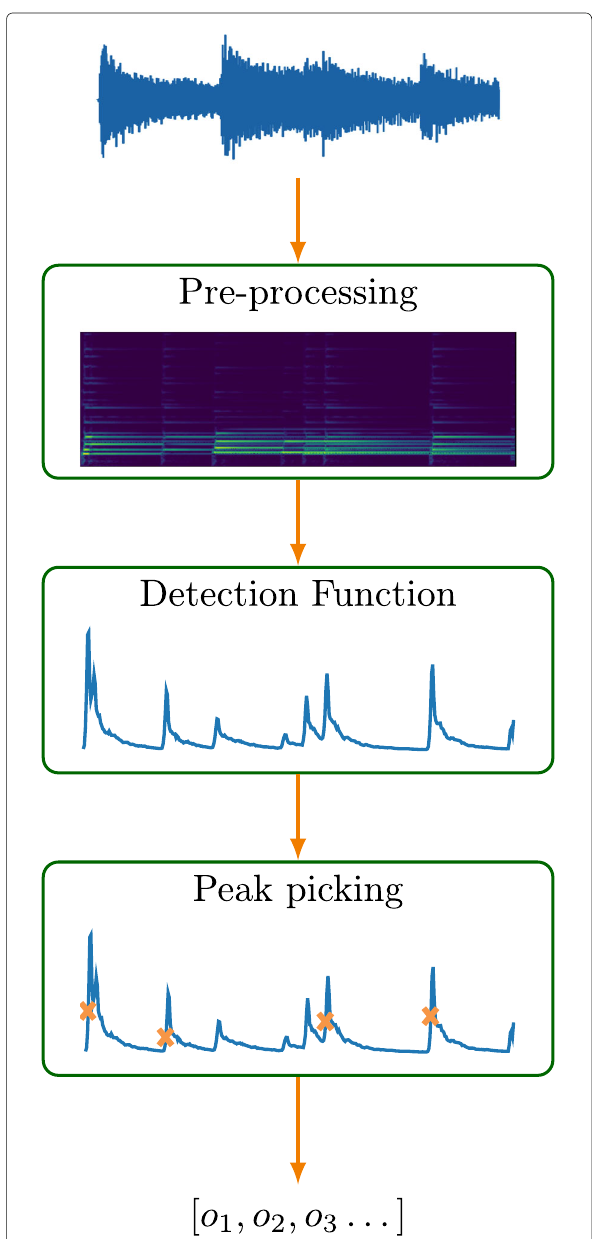
Fig. 1 Solution scheme for NOD. An example of the output of the different steps is shown when NOD is applied on an input